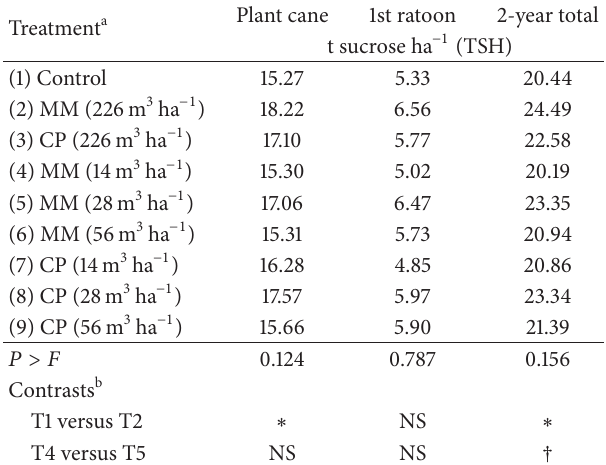
Table 3: Predicted least squares means and 𝑃 > 𝐹 for t sucrose ha −1 (TSH) for individual crop years and cumulative 2-year total at Site 1. Also included are significant contrasts.